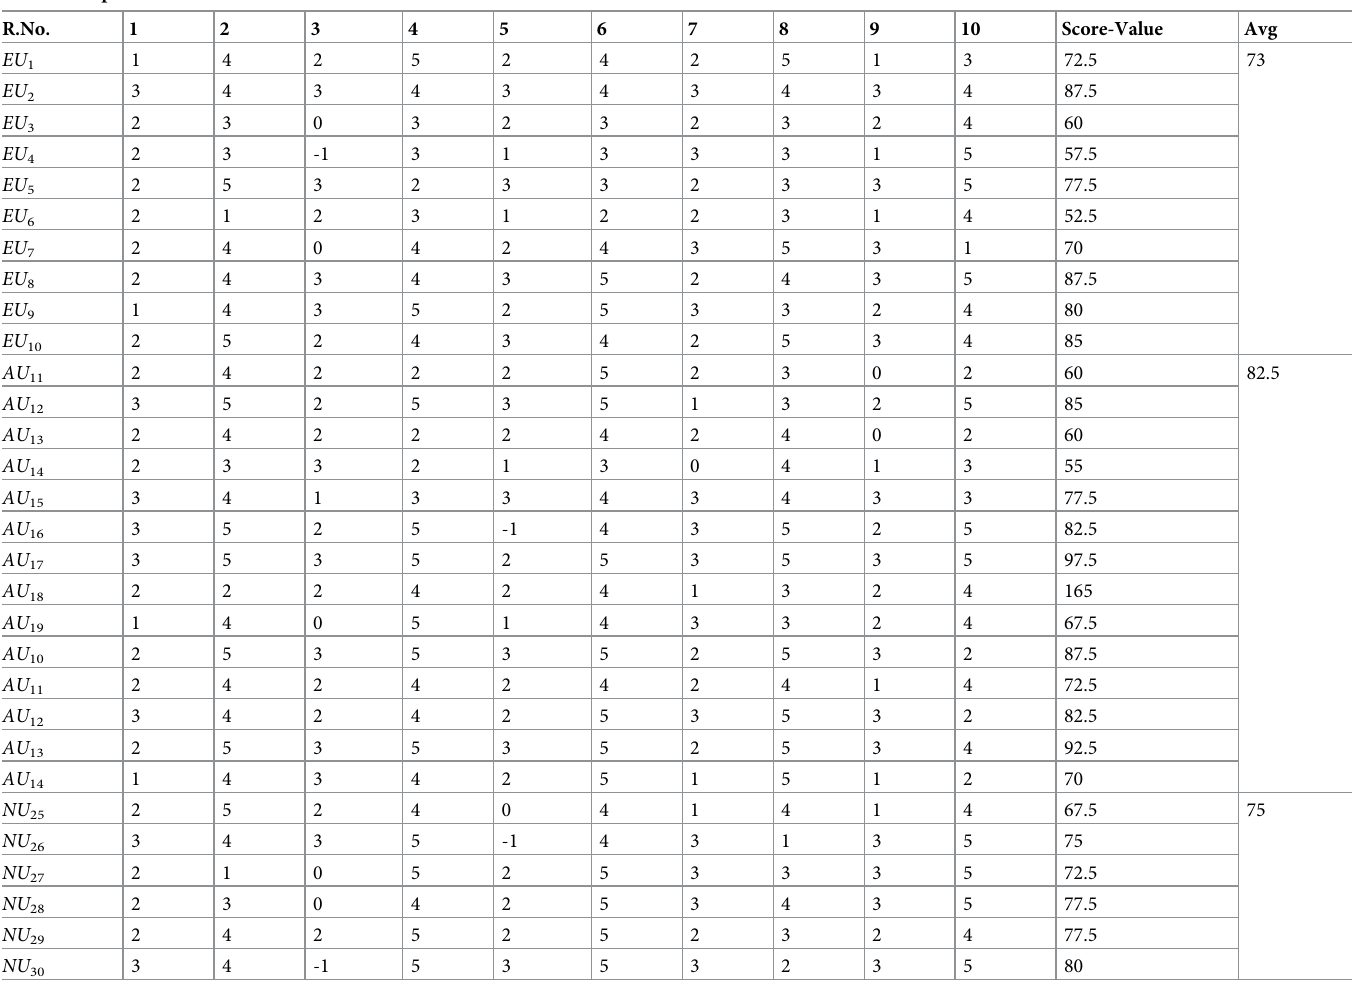
Table 2. Respondents SUS evaluation